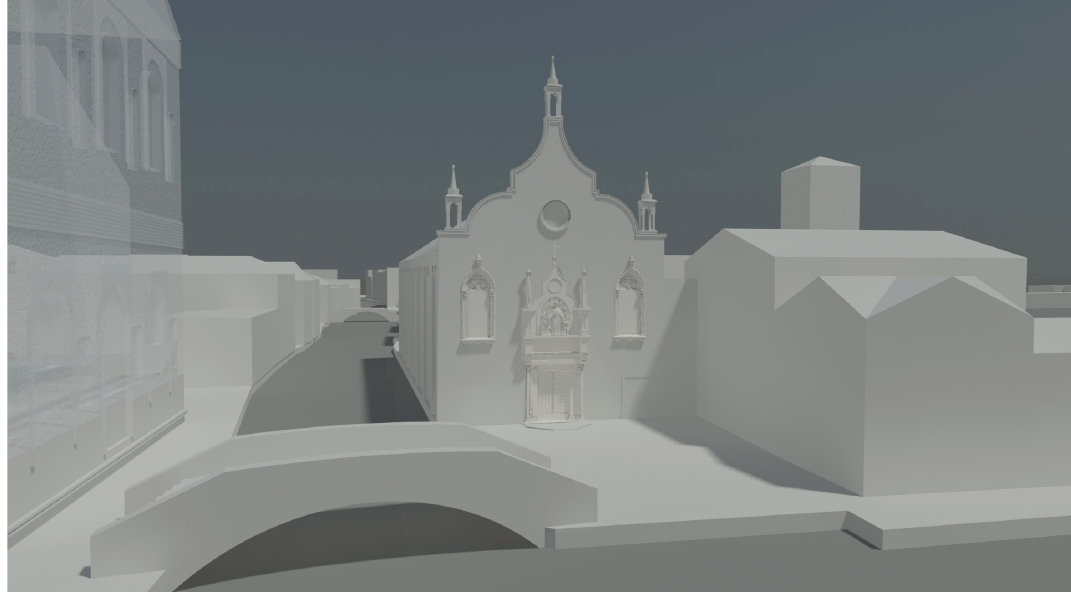
Figure 10: the virtual modelling of the second façade appearance from the XVth to the XVIIth century